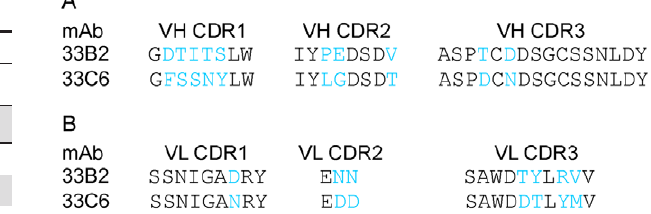
Table 1. Neutralization activity of mAbs 33B2 and 33C6.